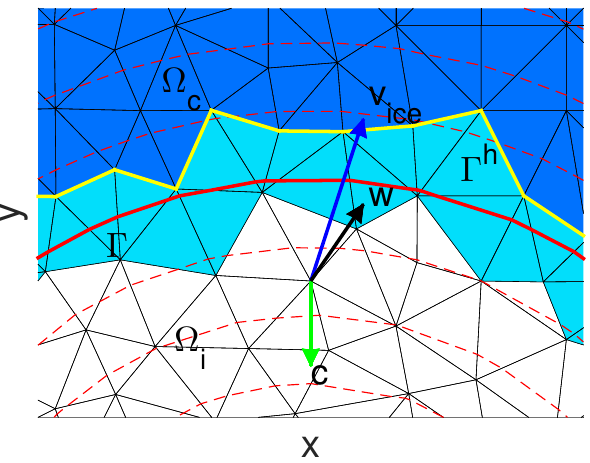
Figure 3. Schematic of the numerical ice margin. The red dashed lines denote different contour lines (level sets) of the LSF ϕ . The thick red line marks the 0 level set, (cid:48) , and the yellow line the nu- merical calving front (cid:48) h . Dark blue triangles are ice-free elements, white ones are ice-filled, and the light blue ones are the front ele- ments. The three vectors show an example of the level-set velocity w = v + c , c = − c ⊥ n at a finite element